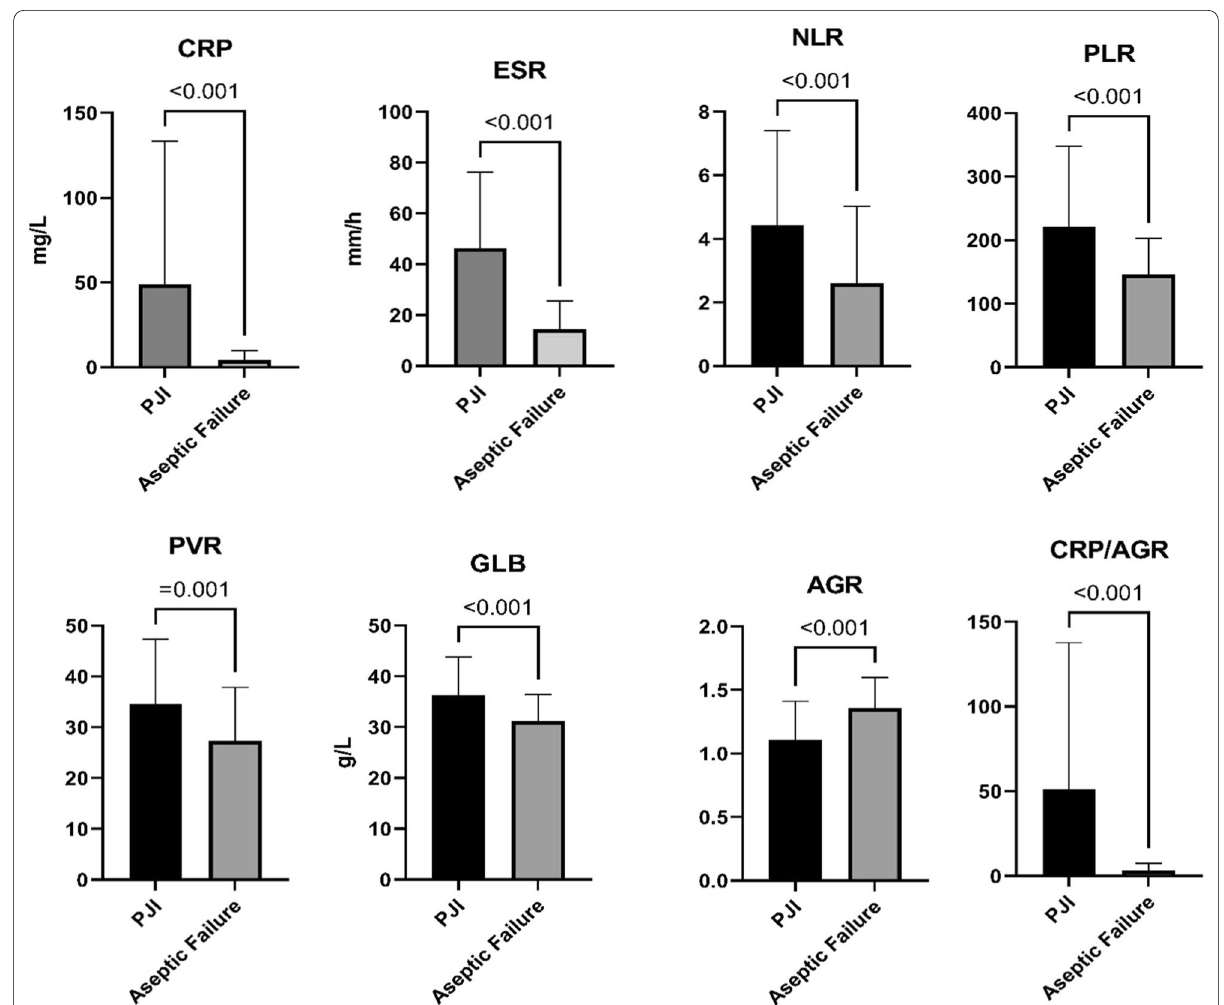
Fig. 2 Comparison of all biomarkers between the PJI group and the aseptic failure group